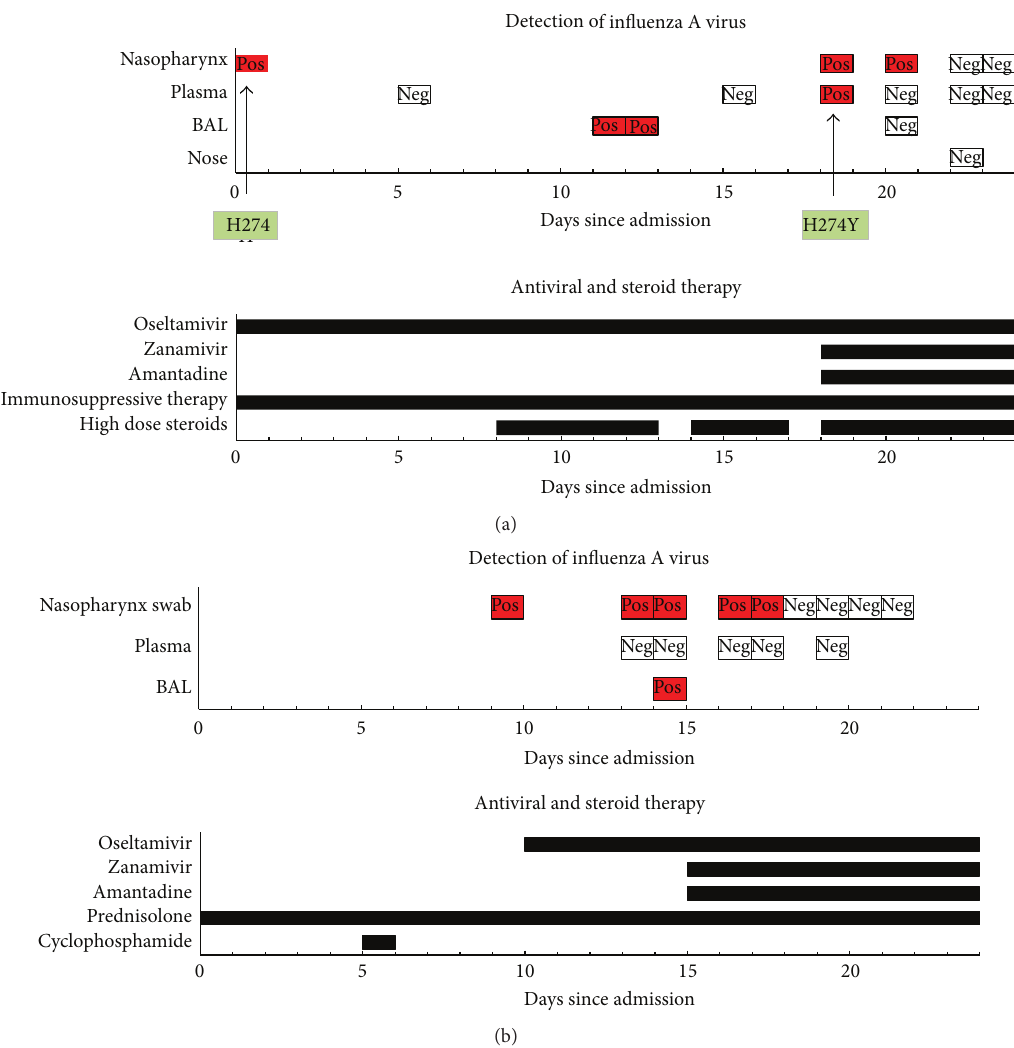
Figure 1: (a) Overview of antiviral and steroid therapy and test results in patient 1. (b) Overview of antiviral and steroid therapy and test results in patient 2.